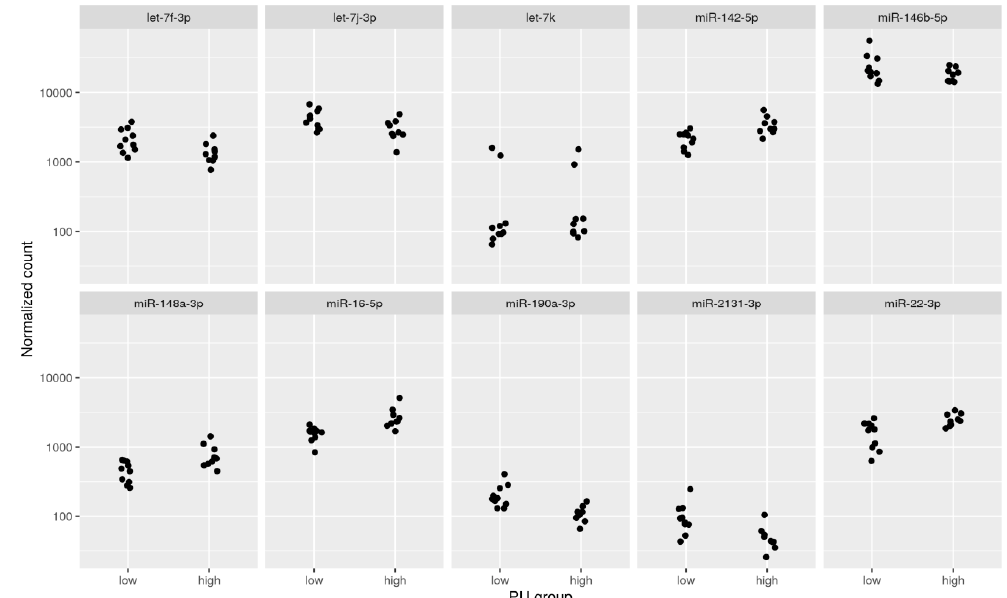
Figure 2. Normalized counts of miRNA expression pattern between P utilizations groups (PU) for the top 10 known miRNAs with the lowest s -values between PU groups ( n = 19). The plot was created using the DESeq2 function plotCounts() and the R package ggplot2.